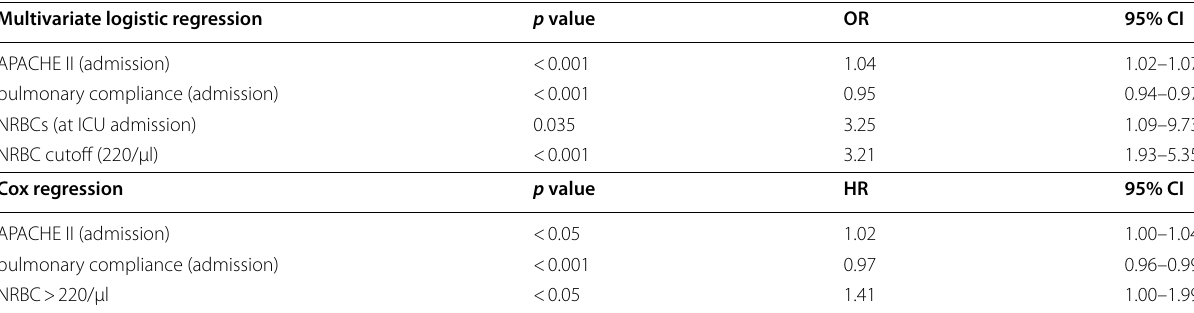
Parameters considered in the multivariate regression models using backwards selection that had significant impact in univariate analyses: age, gender; ICU admission scores (APACHE, SOFA); severe ARDS (yes/no); P peak (peak ventilatory pressure); pulmonary compliance; NRBC (yes/no > 220/µl); (ECMO (yes/no). Data of 404 patients were considered. NRBC cutoff 220/µl was used for analysis. OR odds ratio; CI confidence interval; HR hazard ratio; APACHE II Acute Physiology And Chronic Health Evaluation II; NRBC nucleated red blood cells